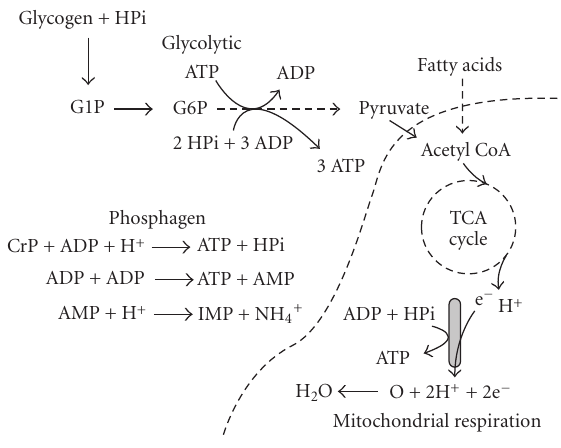
Figure 2: The three energy systems of muscle ATP regeneration.